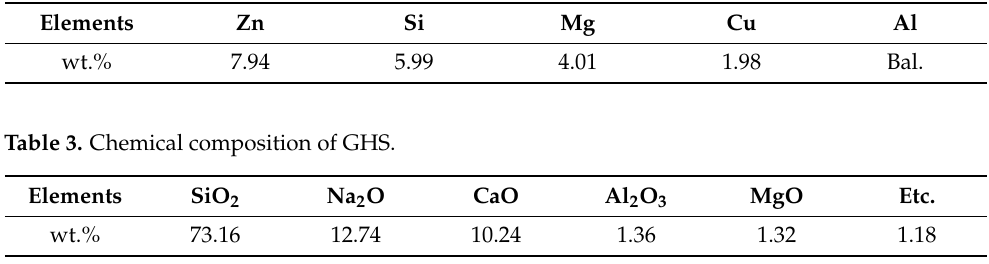
Figure 2. Particle size distribution and volume percentile of GHS. Table 2. Chemical composition of Al-8Zn-6Si-4Mg-2Cu alloys. Table 2. Chemical composition of Al-8Zn-6Si-4Mg-2Cu alloys.